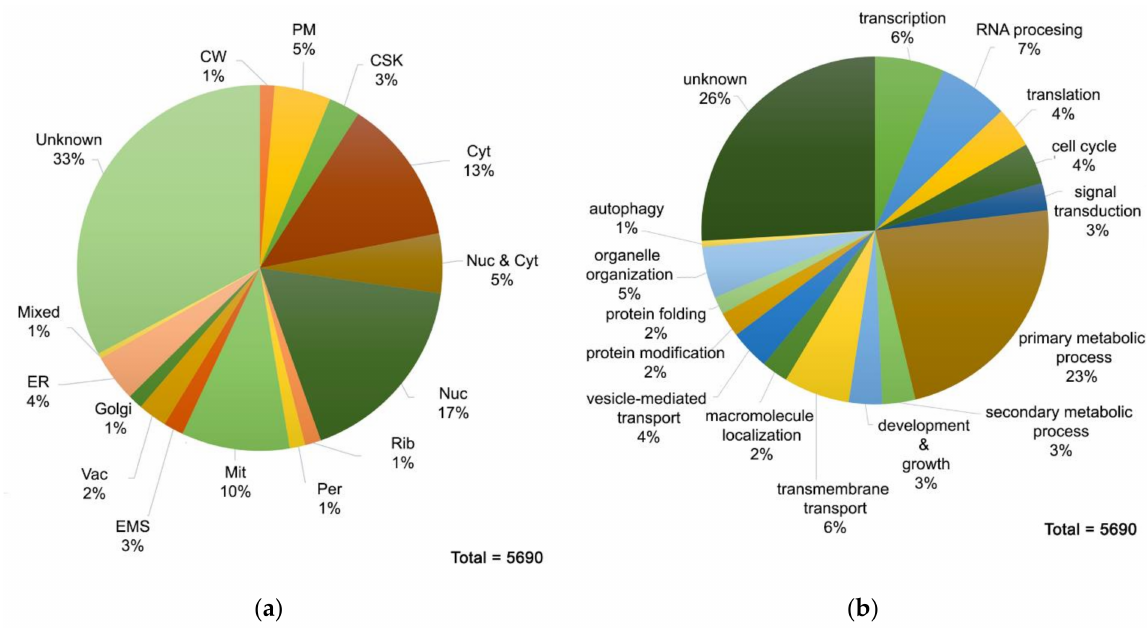
Figure 1. ( a ) Subcellular distribution of A. nidulans proteins. Abbreviations: Nuc, nucleus; Cyt, cytosol; PM, plasma membrane; CW, cell wall; CSK, cytoskeleton, Rib, ribosome; Per, peroxisome; Mit, mitochondrion; ER, endoplasmic reticulum; EMS, endomembrane system; Vac, vacuole. Notice the chart represents general categorization of proteins based in the majority of cases on the putative biological process as defined in AspGD and FungiDB. This means that several cytosolic proteins which might possess cryptic location signals might in fact be organellar. Thus, this pie chart is a gross representation of functional categories, as also appears in genome annotations. ( b ) Functional classification of A. nidulans